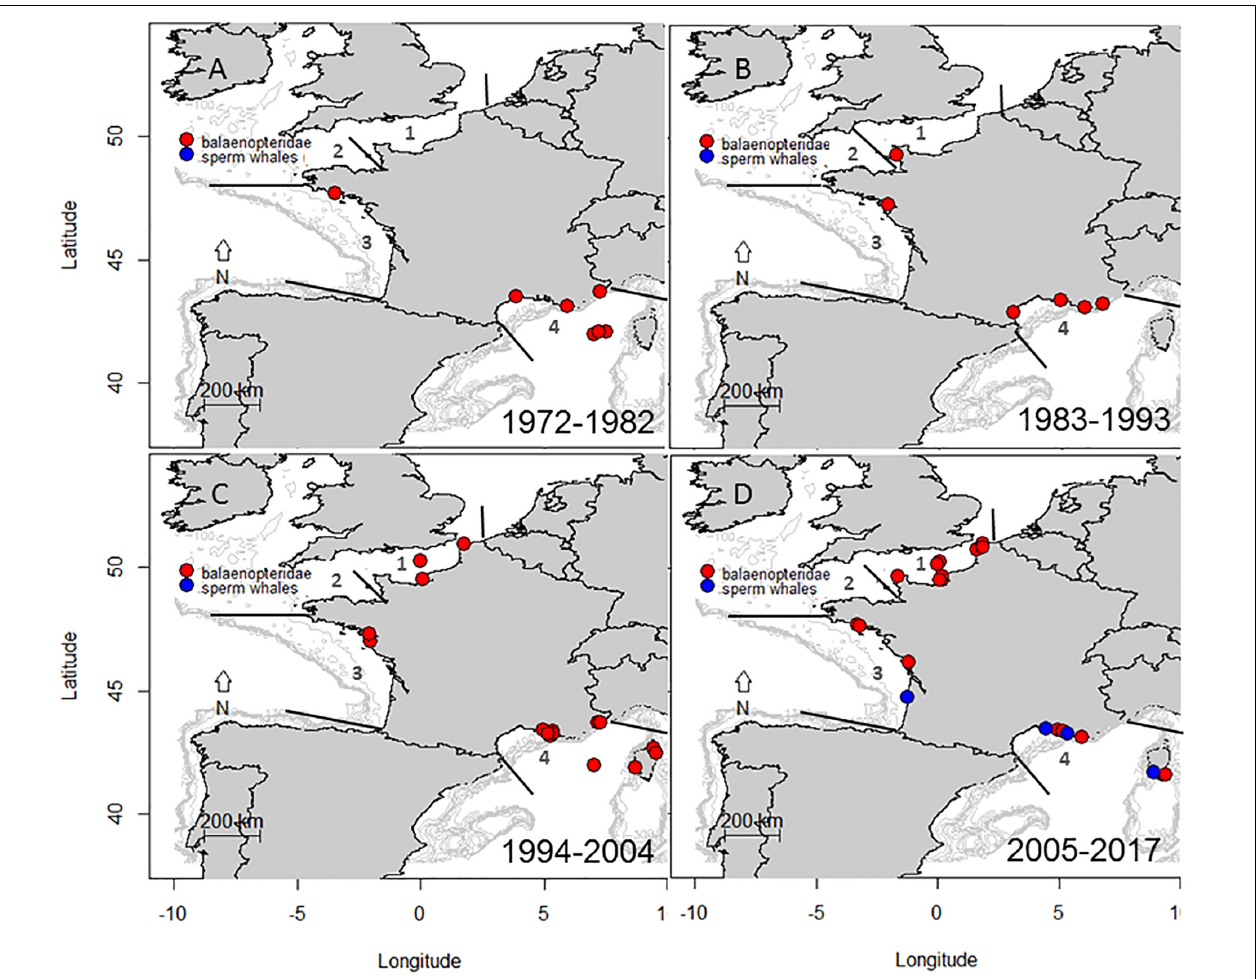
FIGURE 2 | Geographic distribution of balaenopterid (red dots) and sperm whale (blue dots) strandings with evidence of lethal ship strikes per decade ( A : 1972–1982; B : 1983–1993; C : 1944–2004; D : 2005–2017). Dots depict an individual stranding event. Marine sub-regions are presented (1 = Channel and North Sea; 2 = Celtic Sea; 3 = Bay of Biscay; 4 = Western Mediterranean